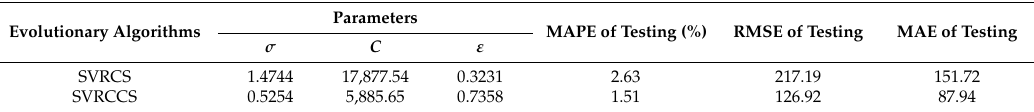
Table 1. Three parameters of SVRCS and SVR with chaotic cuckoo search (SVRCCS) models for Example 1.